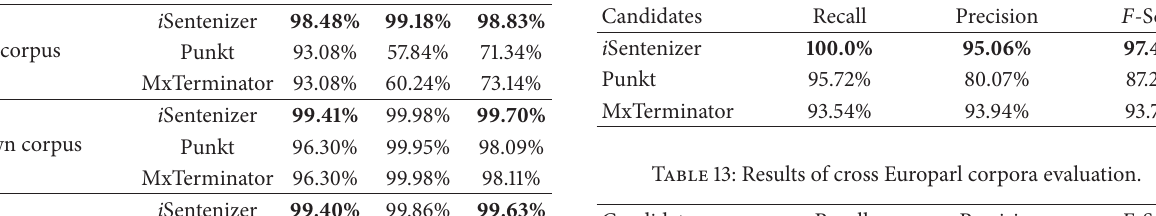
Table 10: Results on the Brown, WSJ, and Tycho Brahe corpus. Corpus